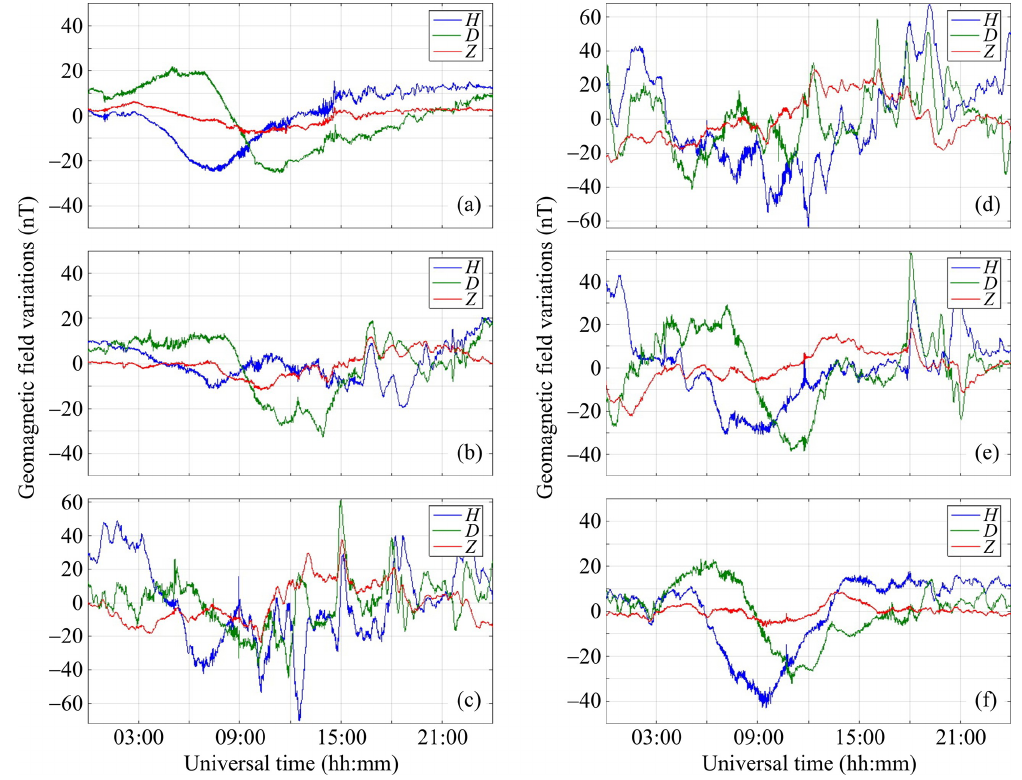
Figure 3. H , D , and Z components for (a) 29 August 2019, (b) 30 August 2019, (c) 31 August 2019, (d) 1 September 2019, (e) 2 Septem- ber 2019, and (f) 3 September 2019 (http://geospace.com.ua/en/observatory/metmag.html, last access: 18 June